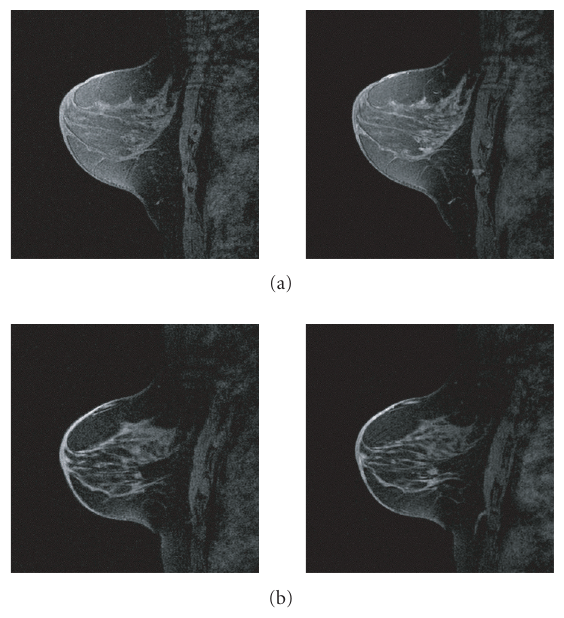
Figure 3: Sample MR pre- and postcontrast images at (a) 0 month and (b) 3 months: (left) precontrast image and (right) postcontrast image.